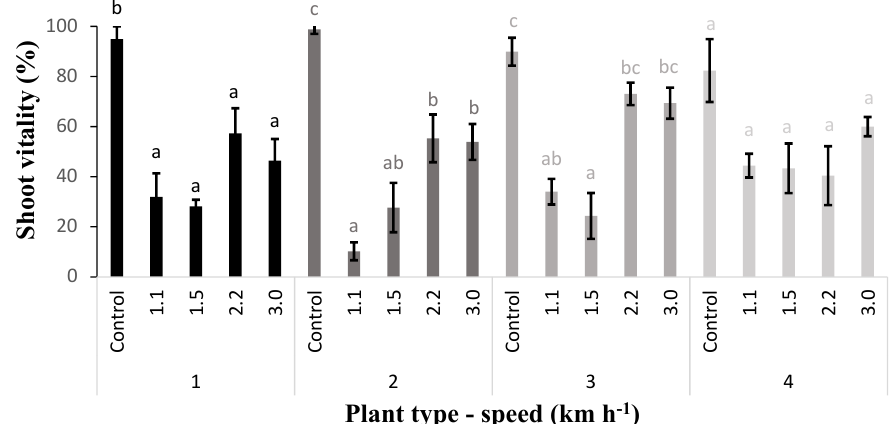
Figure 4. Shoot vitality (%) of electrocuted C. esculentus plants for each combination of plant type and speed (km·h − 1 ) in the Zasso experiment at Bocholt in 2021. Means sharing the same letter are not significantly different ( p < 0.05); comparison within plant type only. Shoot vitalities of plant types within speeds were only significantly different when plants were electrocuted at the lowest speed (1.1 km·h −1 ) (Figure 5). At this speed shoot vitality of plant type 2 was significantly 34.2% lower than shoot vitality of plant type 4.